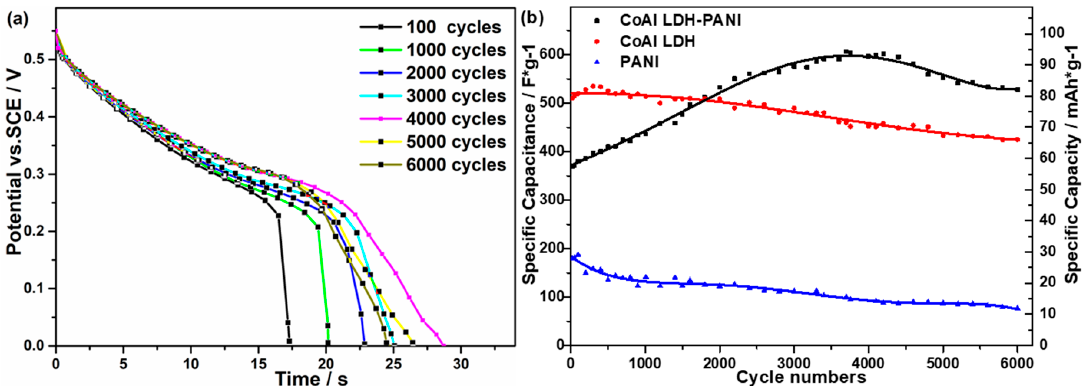
Figure 8. ( a ) Galvanostatic discharge curves of the CoAl LDH-PANI electrode at different scan cycles. ( b ) Cycling performance of the CoAl LDH, PANI, and CoAl LDH-PANI electrodes, respectively. (Current density 10 A/g)